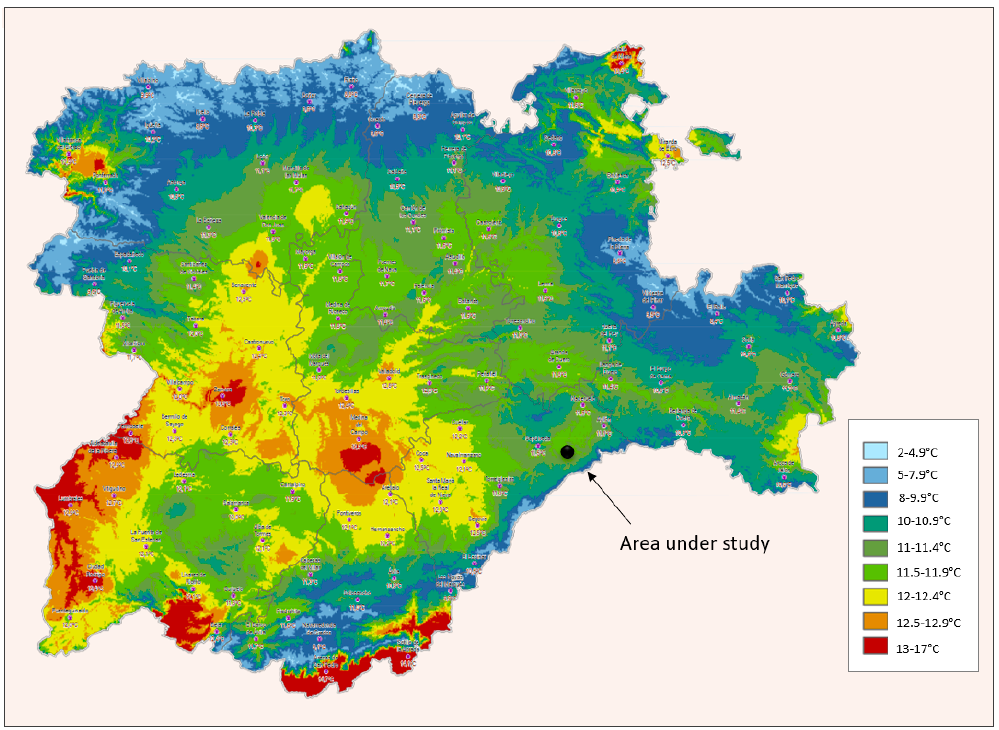
Figure A3. Average annual temperature in the area considered in this research for the period 1981– 2010 [39].